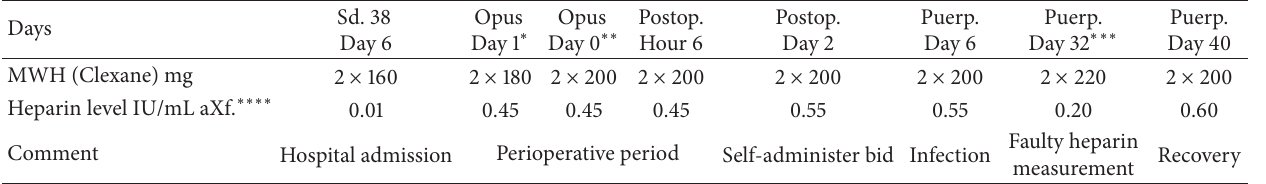
Table 1: Pre-, peri-, and postoperative days the examine and follow the efficiency of heparin therapy by monitoring of anti-Xa activity.